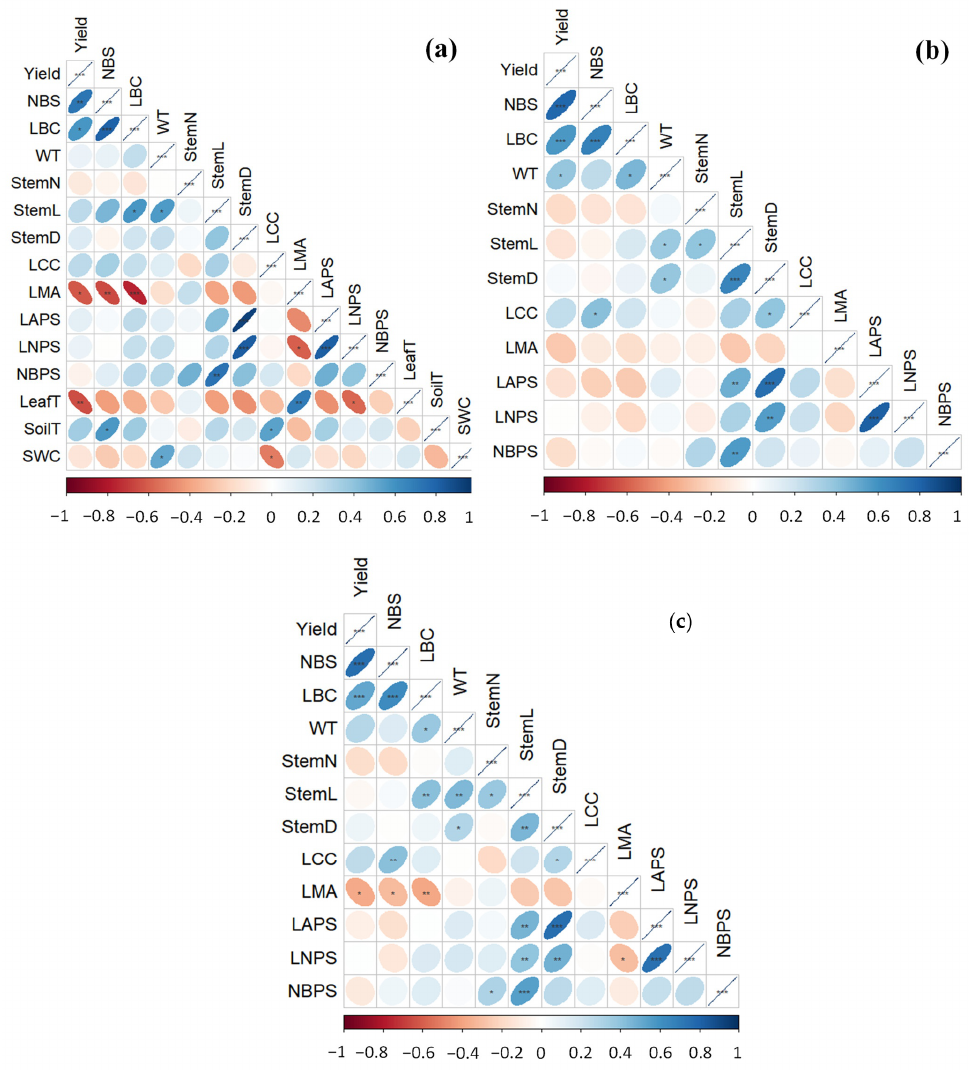
Figure 3. Pearson correlation heat map of the structural, functional, and yield-related traits of wild blueberries for ( a ) Wyman’s field, ( b ) BBHF field, and ( c ) the combined data from both fields. The horizontal axis represents the degree and direction of Pearson correlation r. The sign of the significance for each correlation is shown as ***, p < 0.001; **, p < 0.01; *, p < 0.05. For definitions of trait abbreviations, please see Table 1. LeafT, SoilT, and SWC data were only available for the Wyman’s field.